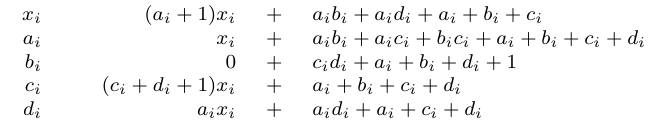
Table 2: ANF of Column i after initialization (left) and after the first S-box layer